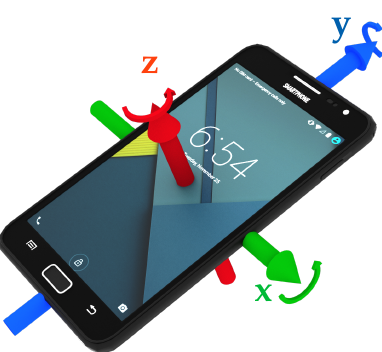
Figure 1. Coordinate system used for sensor data measured on smartphones using the iOS or Android operating